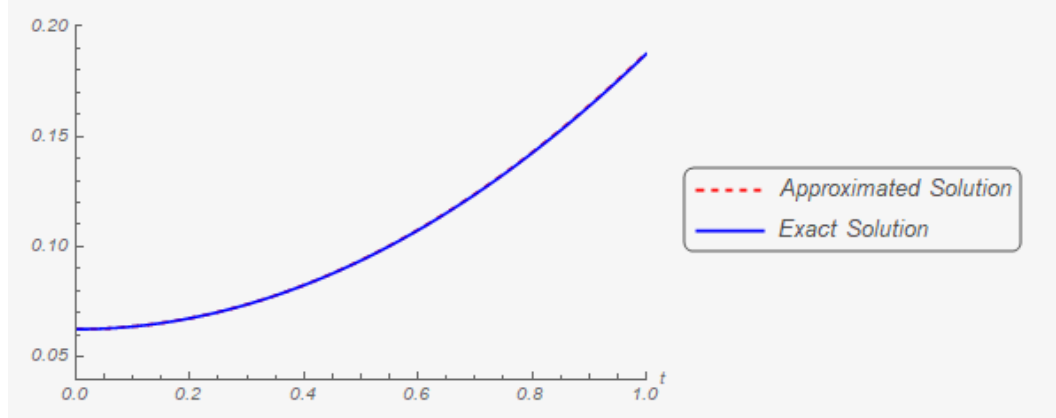
Figure 11. The first component of the exact solution and its two hundredth and fifth